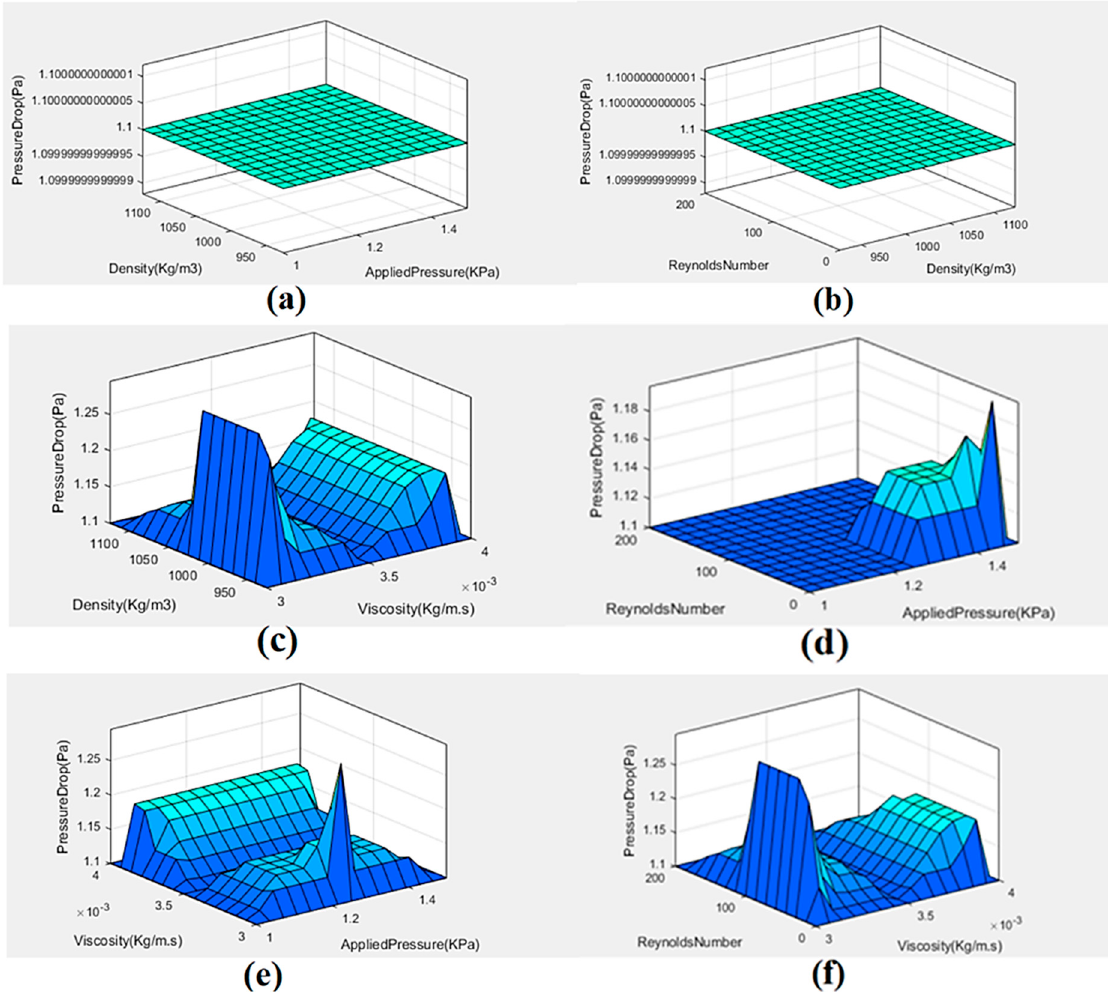
Figure 9. 3D graphical variations with inputs Reynolds Number, applied pressure, viscosity, and density with flow rate as output ( a ) Variation for applied pressure with density and pressure drop as output ( b ) Variation for Reynolds number with density and pressure drop as output ( c ) Variation for viscosity with density and pressure drop as output ( d ) Variation for applied pressure with Reynolds number and pressure drop as output ( e ) Variation for applied pressure with viscosity and pressure drop as output ( f ) Variation for Reynolds number with viscosity and pressure drop as output. Table 3. Results assessment for both types of microchannels (Mamdani’s numerical value with Fuzzy simulation MATLAB).